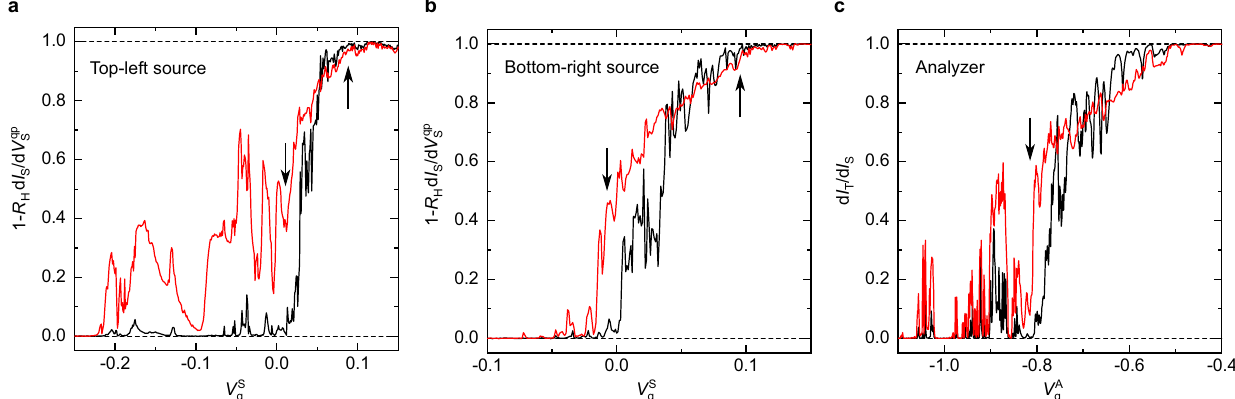
Fig. 7 | Quantum point contacts vs gate voltage. a b Differential transmission ratio1 (cid:3) R H d I S = d V qp S ofthetop-left(bottom-right)sourceQPC,asafunctionofthe voltage V S g applied to the source QPC gate located the furthest from the analyzer QPC. The black and red continuous lines correspond to measurements in the presenceofadcvoltagebias V qp S =0 μ Vand V qp S = (cid:3) 43 μ V,respectively. c Analyser